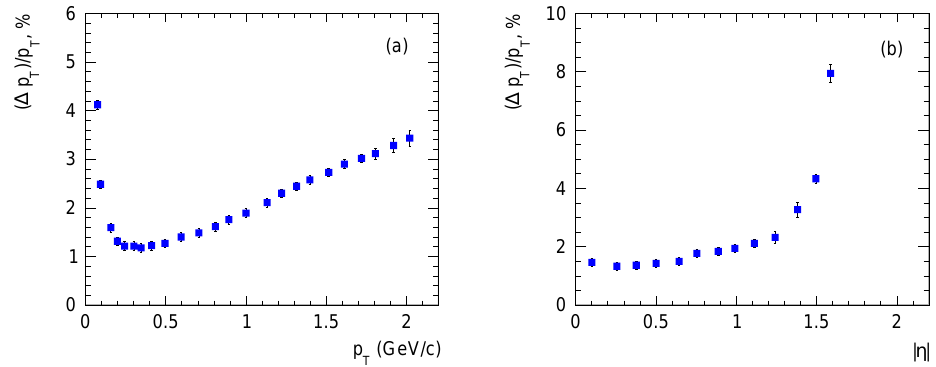
Figure 2. Relative transverse momentum resolution for primary tracks as a function of p T ( a ) and pseudorapidity η ( b ).